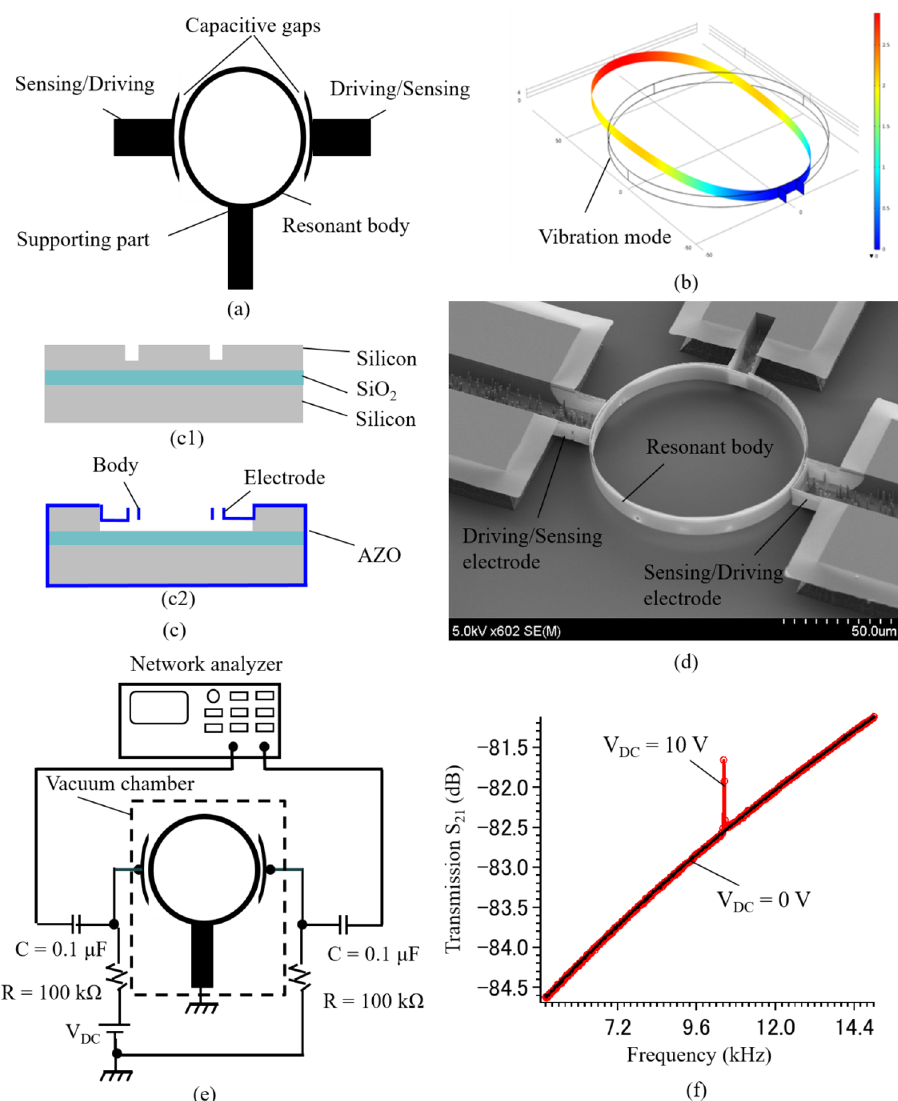
Figure 8. AZO nanomechanical resonator. ( a ) Vertical nanomechanical capacitive resonator. ( b ) Vibration mode by FEM simulation. ( c ) Fabrication process. ( c1 ) Silicon pattering. ( c2 ) AZO capacitive resonator. ( d ) Fabricated AZO capacitive silicon resonator. ( e ) Evaluation setup. ( f ) Frequency response of the AZO capacitive